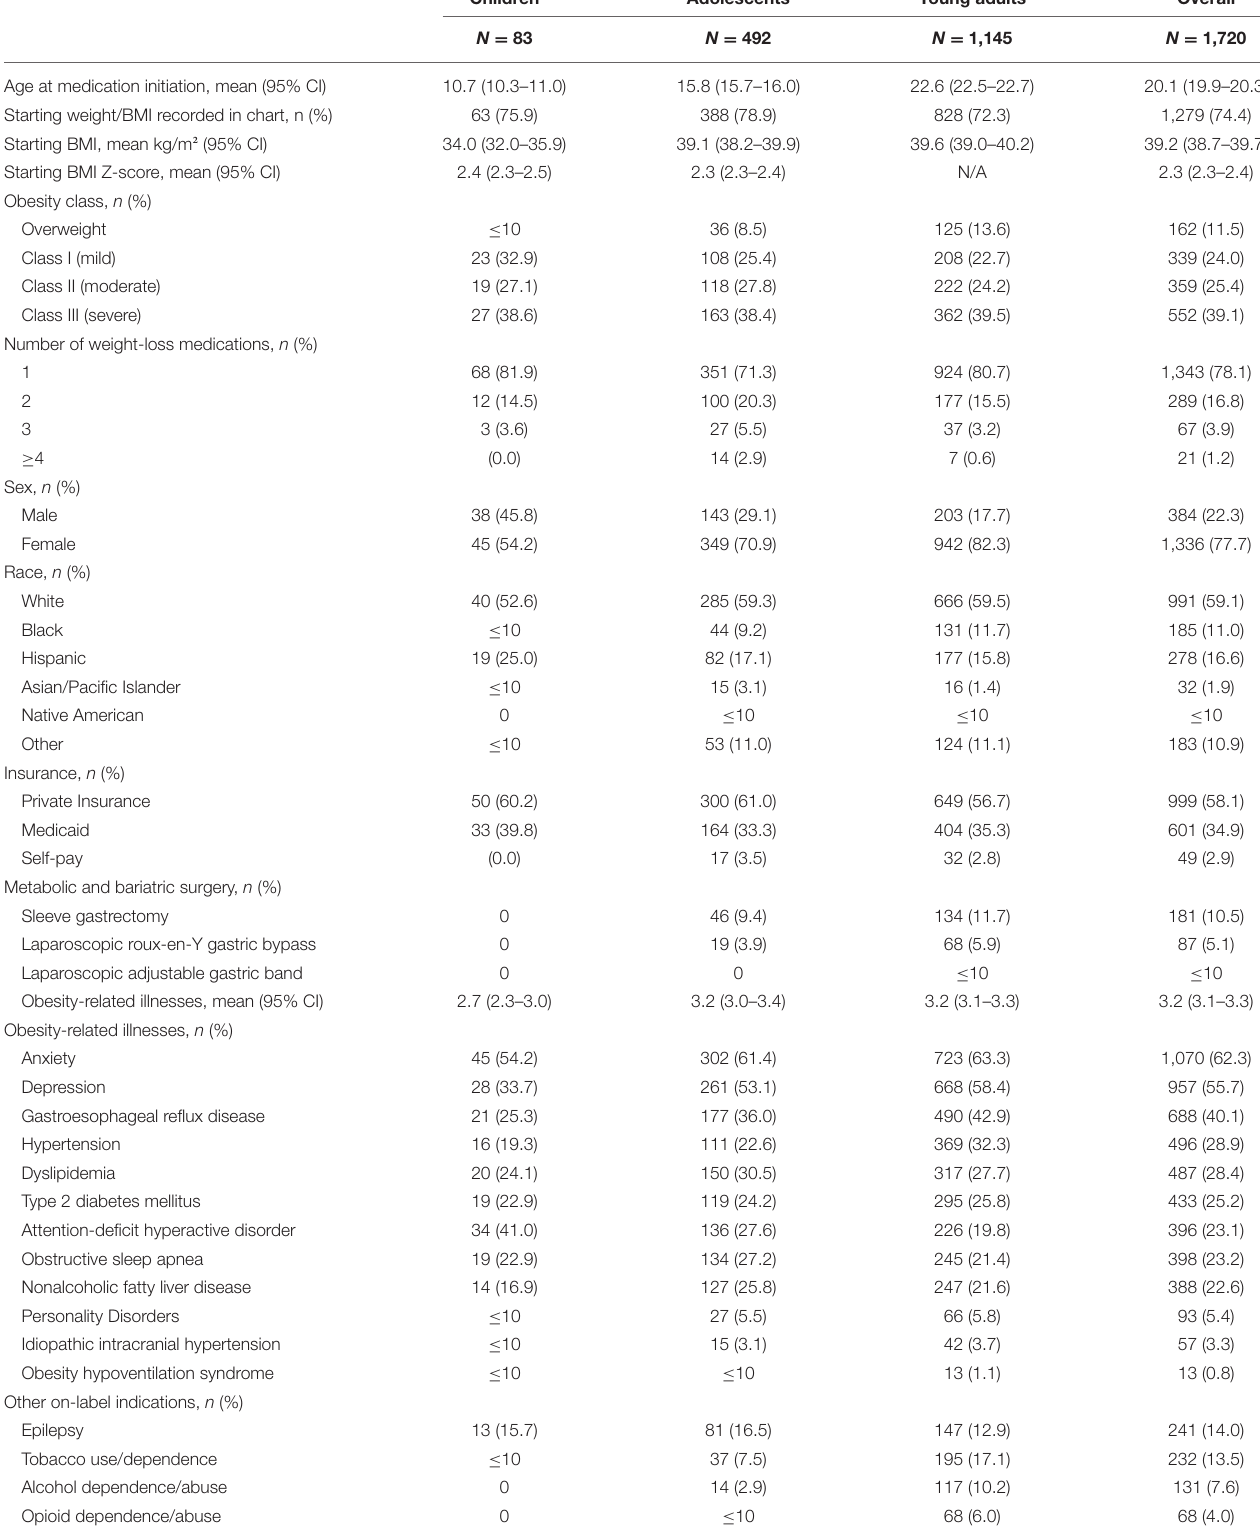
TABLE 2 | Patient demographics and clinical